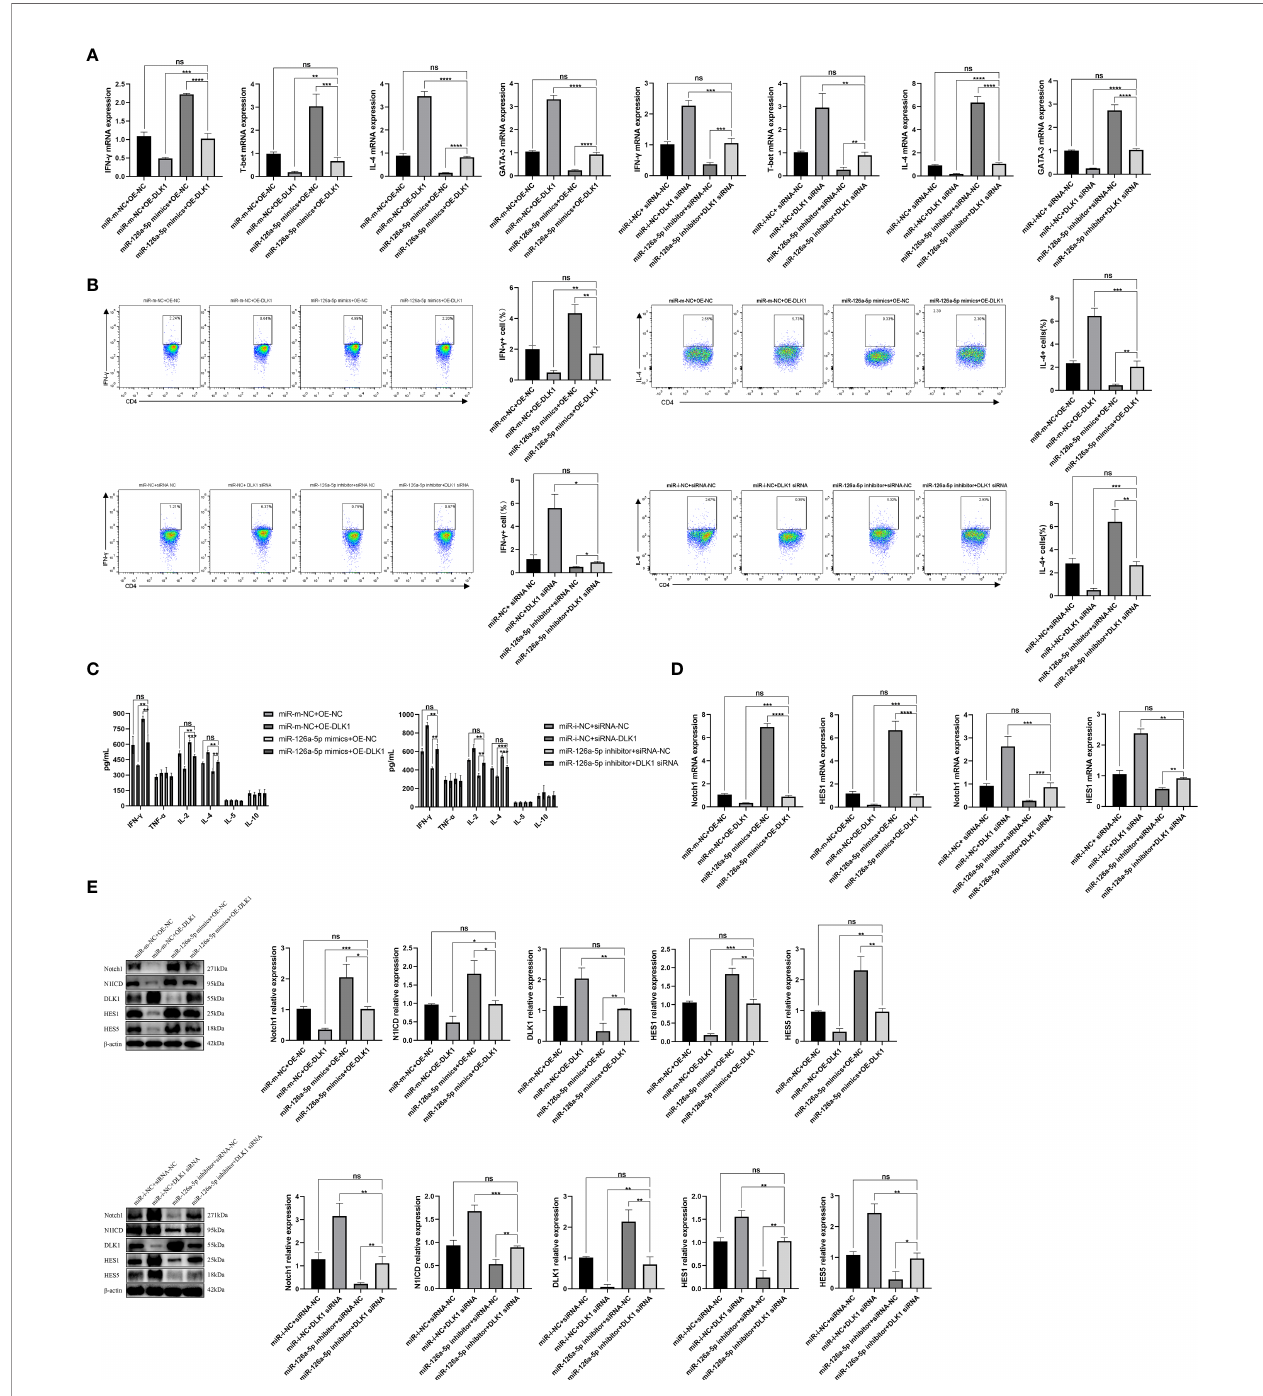
FIGURE 5 | miR-126a-5p and DLK1 together can rescue the naive CD4 + T-cell differentiation induced by their separate actions. (A) The mRNA expression of IFN- g , T-bet, IL-4, and GATA-3 after transfection with miR-126a-5p mimics+OE-DLK1 or miR-126a-5p inhibitor+DLK1 siRNA in naive CD4 + T cells performed by qRT-PCR. (B) The expression of IFN- g and IL-4 after transfection with miR-126a-5p mimics+OE-DLK1 or miR-126a-5p inhibitor+DLK1 siRNA in naive CD4 + T cells conducted by fl ow cytometry. (C) The expression of IFN- g , TNF- a , IL-2, IL-4, IL-5, and IL-10 after transfection with miR-126a-5p mimics+OE-DLK1 or miR-126a-5p inhibitor +DLK1 siRNA in naive CD4 + T cells measured by ELISA. (D) Notch1 and HES1 mRNA expression after transfection with miR-126a-5p mimics+OE-DLK1 or miR- 126a-5p inhibitor+DLK1 siRNA in naive CD4 + T cells determined by qRT-PCR. (E) The protein expression of Notch1, N1ICD, DLK1, HES1, and HES5 after transfection with miR-126a-5p mimics+OE-DLK1 or miR-126a-5p inhibitor+DLK1 siRNA in naive CD4 + T cells by Western blot. * P < 0.05, ** P < 0.01, *** P < 0.001, **** P < 0.0001; ns, not signi fi